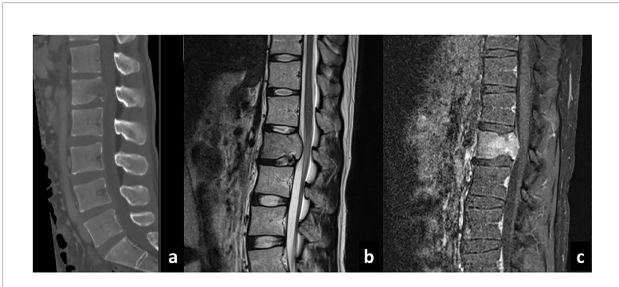
FIGURE 2 Sagittal CT (A) , T2-weighted (B) , and gadolinium-enhanced T1- weighted (C) MRI sequences of the spine showing development of metastatic lesion.